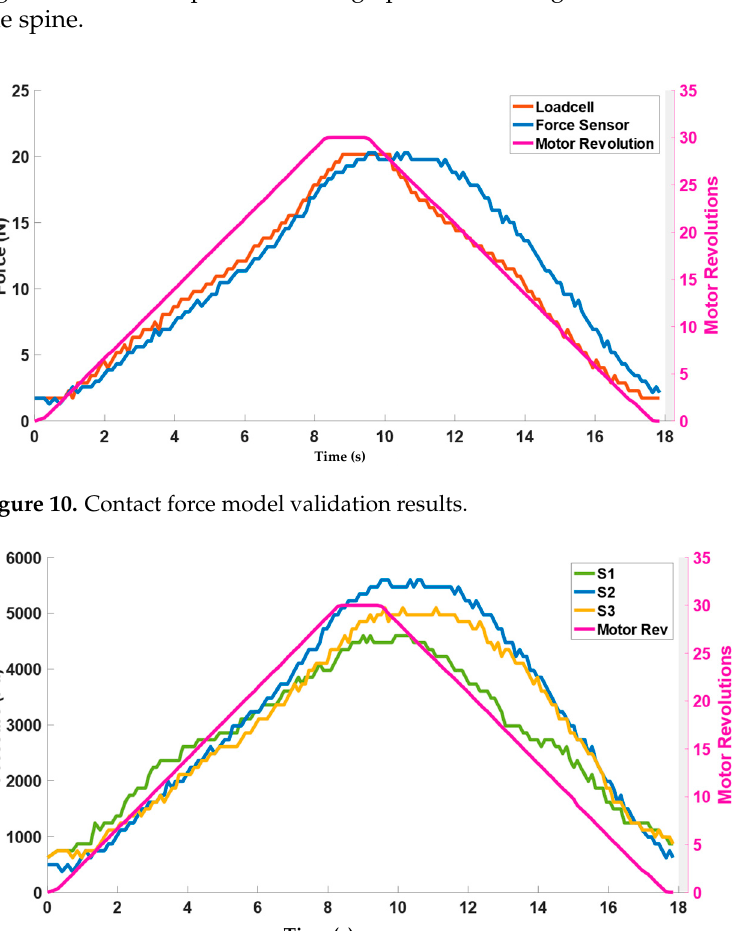
Figure 11. Corresponding pressure range exerted by the elastic bands.